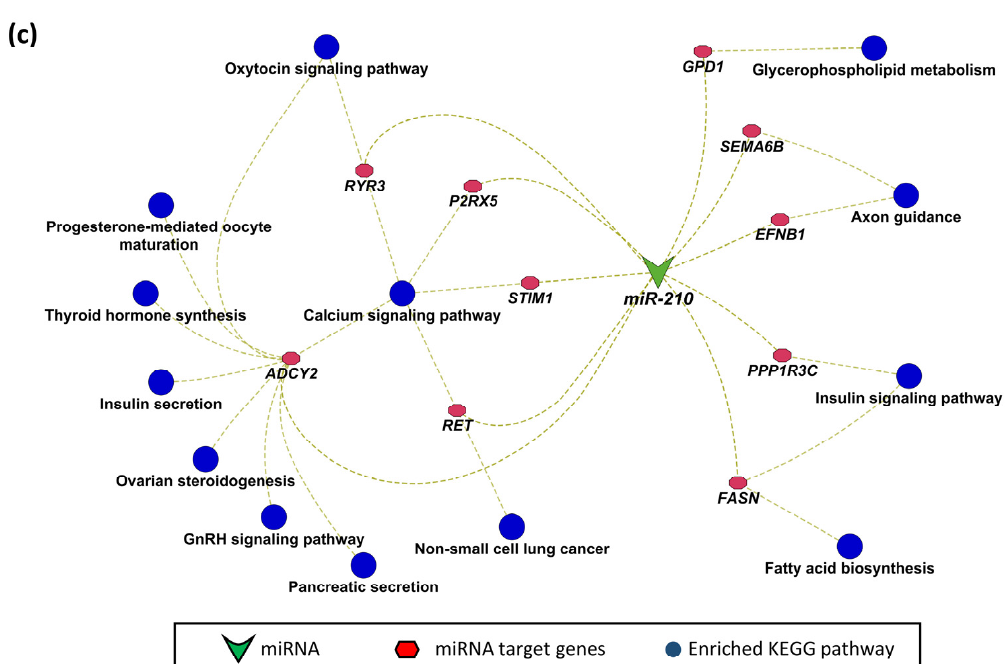
Figure 7. ( a ) Comparison of miRNAs correlated to fetal weight and miRNAs upregulated during IUGR. ( b ) Common miRNAs and their negatively correlated target genes. ( c ) KEGG pathway enrichment analysis of target genes of miR-210.